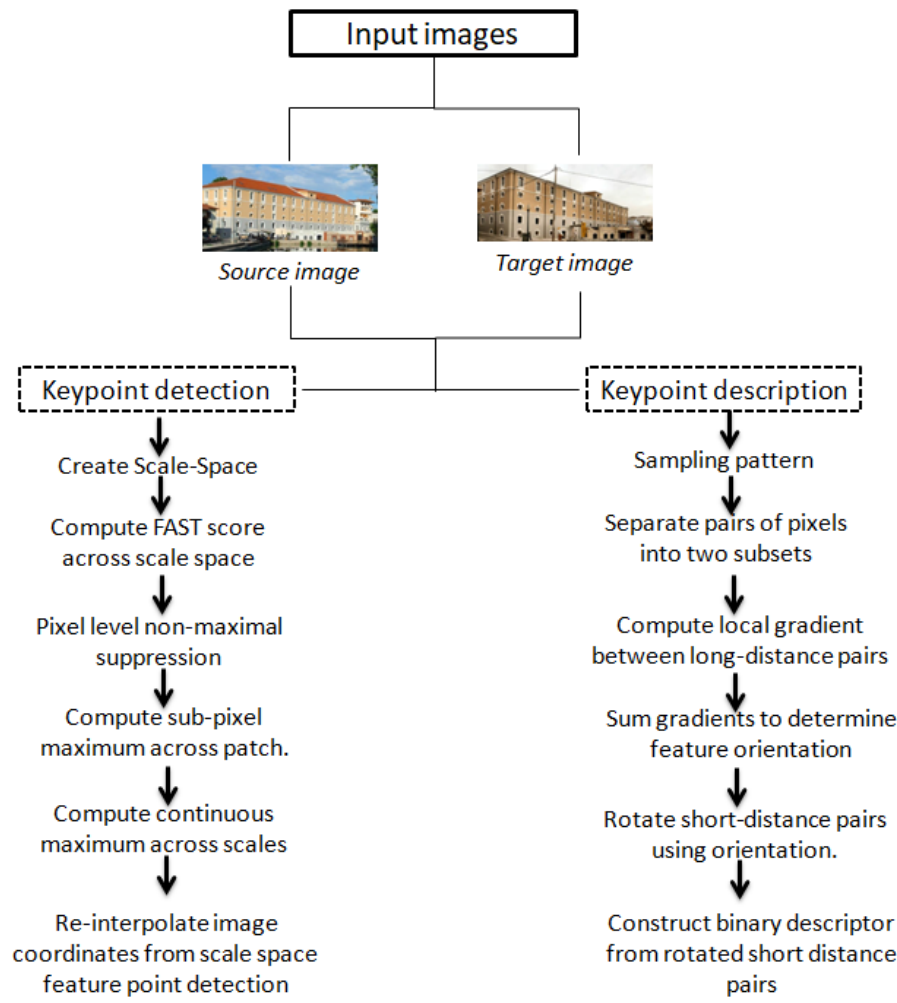
Figure 11. Workflow of BRISK algorithm scale-space keypoint detection: points of interest are identified across both the image and scale dimensions using a saliency criterion. Keypoints are detected in octave layers of the image pyramid. Keypoint description: a sampling pattern consisting of points lying on appropriately scaled concentric circles is applied at the neighborhood of each keypoint to retrieve gray values (processing local intensity gradients and the feature characteristic direction is